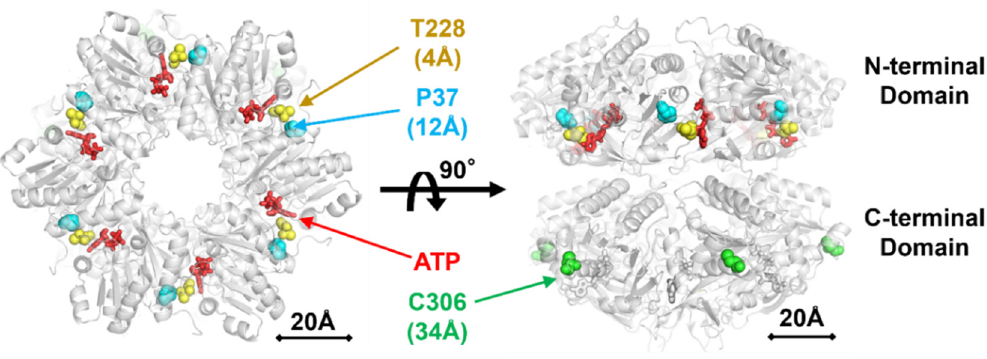
Figure 7. Three representative KaiC mutations (Pro37, Thr228, and Cys306) mapped on the crystal structure of wild-type KaiC carrying no alanine substitutions (accession code: 2GBL) [20]. Shown are distances to the nearest ATP in the N-terminal domain.